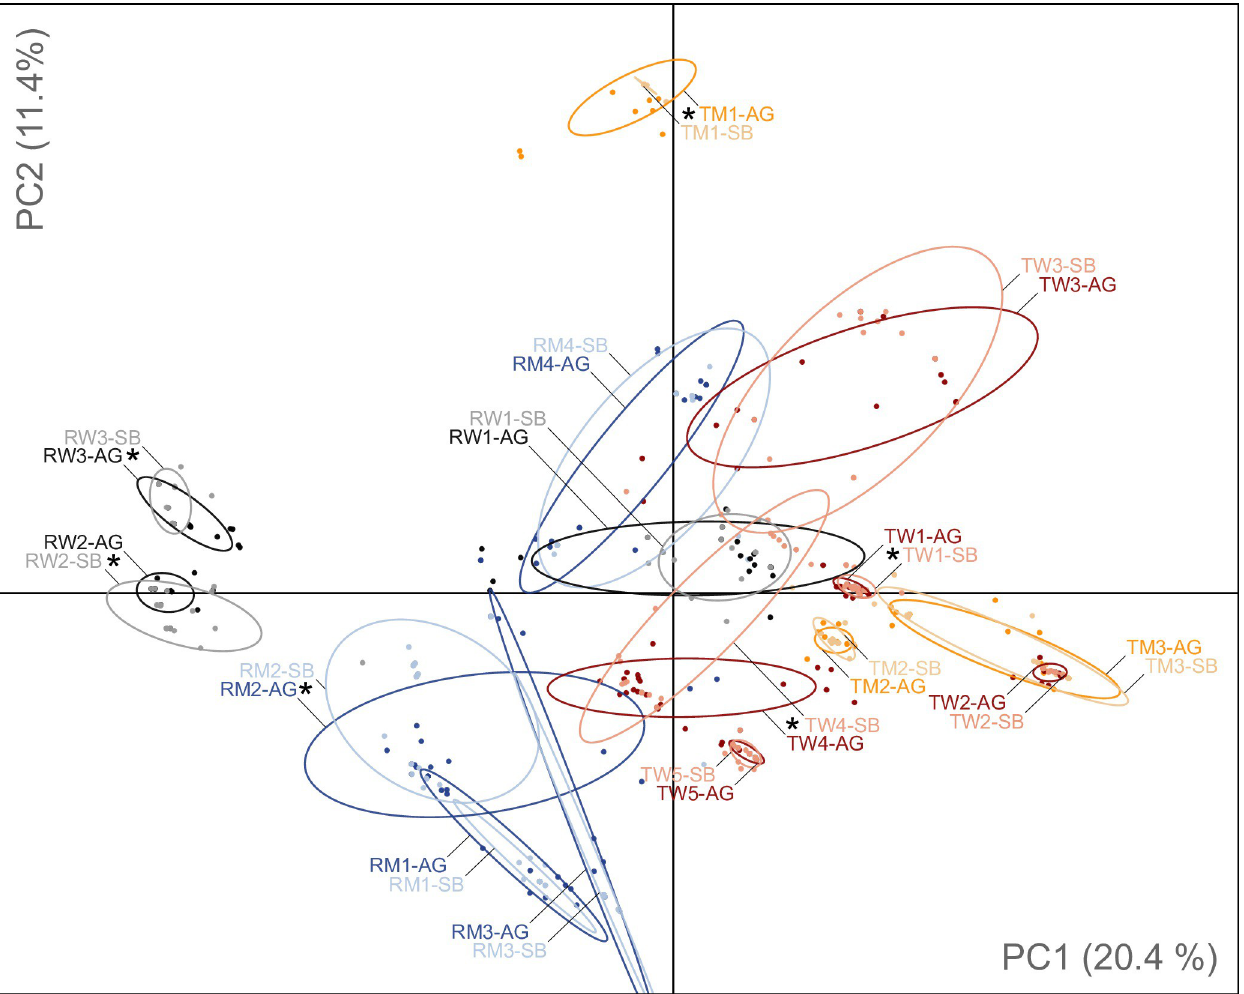
Fig 3. Principal component analysis (PCA) of the genetic structure in populations of Viola elatior . German populations are indicated by blue (meadow) and grey (woodland), and Czech populations by orange (meadow) and red (woodland). Aboveground and seed bank cohorts are depicted by strong and light colors, respectively. Inertia ellipses indicate dispersion of samples in relation to mean coordinates and include approximately three-fourths (76%) of all individuals for each group. Stars denote populations with significant genetic differentiation ( ф ST ) between aboveground and seed bank cohorts (see also S3